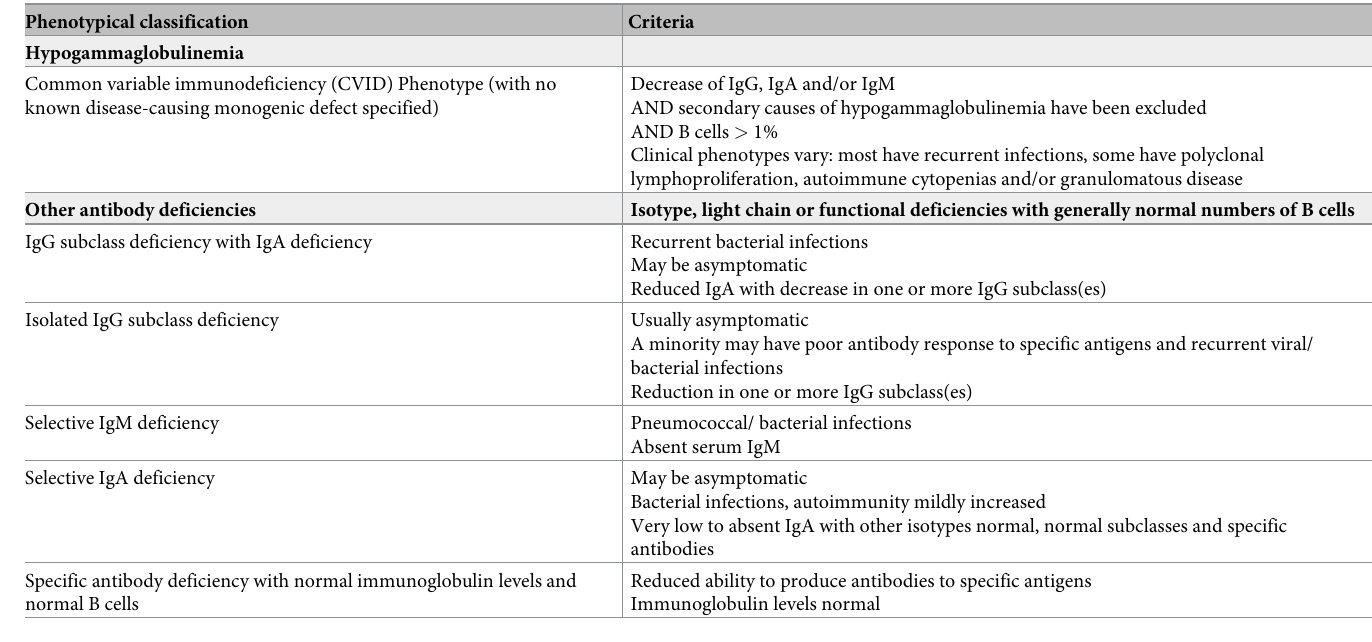
Table 1. IUIS phenotypical classification–predominantly antibody deficiencies (without an identified monogenetic